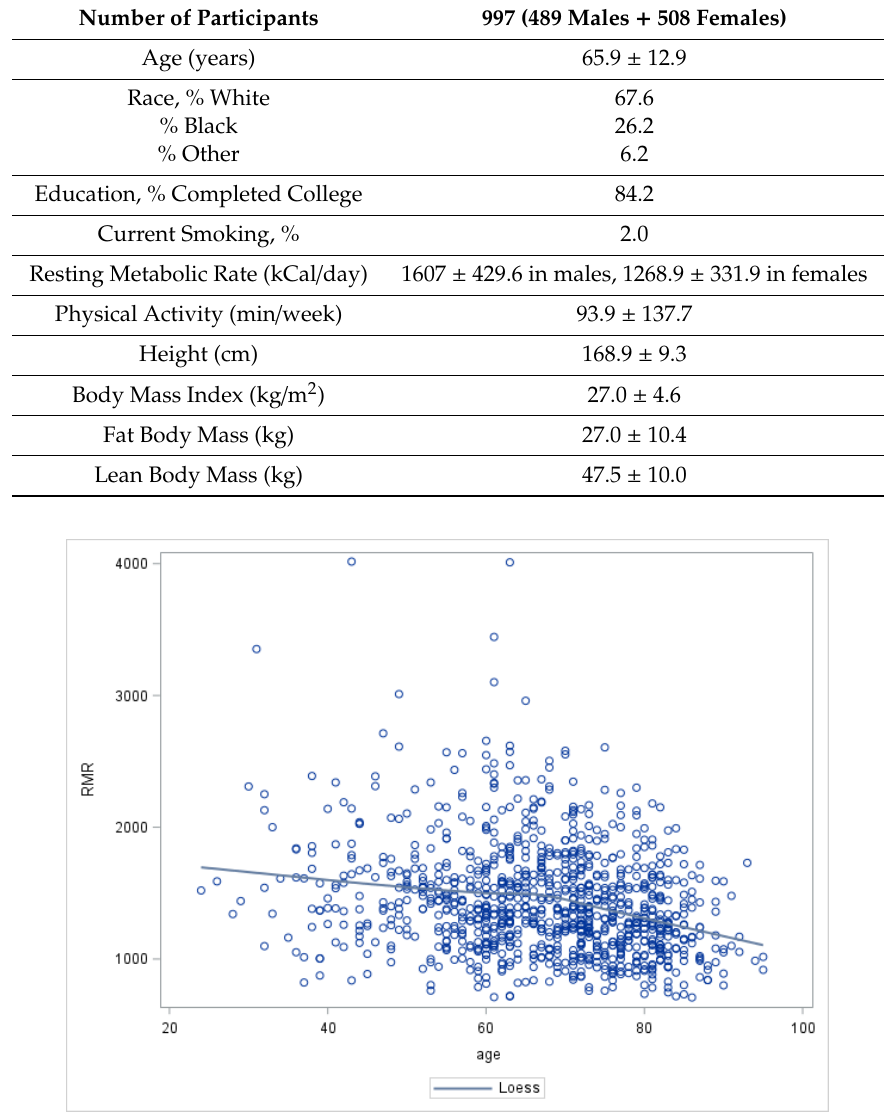
Table 1. Characteristics of the population at baseline (average ± standard deviation).